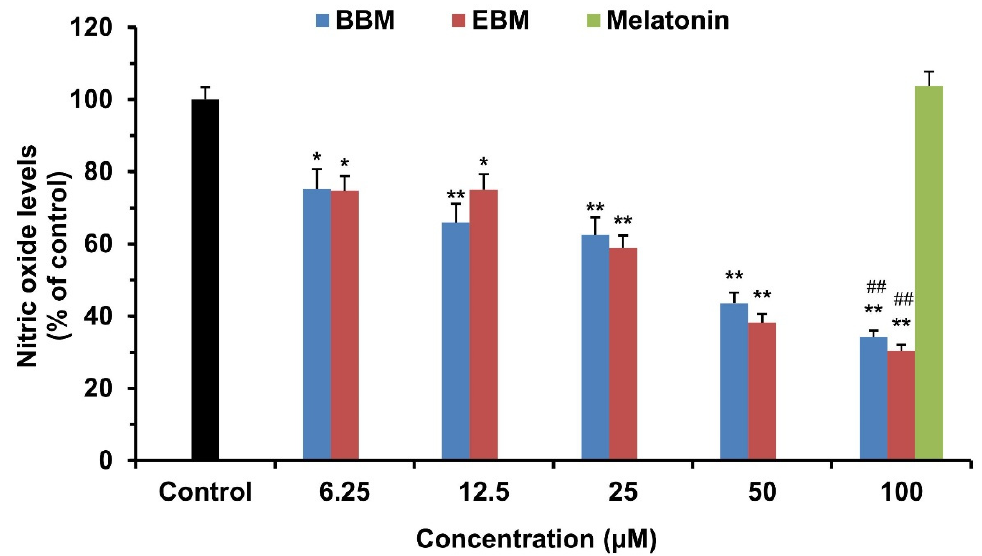
Figure 3. Effect of melatonin, BBM and EBM on the production of nitric oxide in LPS-stimulated RAW 264.7 cells. Values are expressed as the means ± S.E.M * p < 0.05, ** p < 0.001 versus vehicle treatment group, ## p < 0.001 versus melatonin 100 µM.